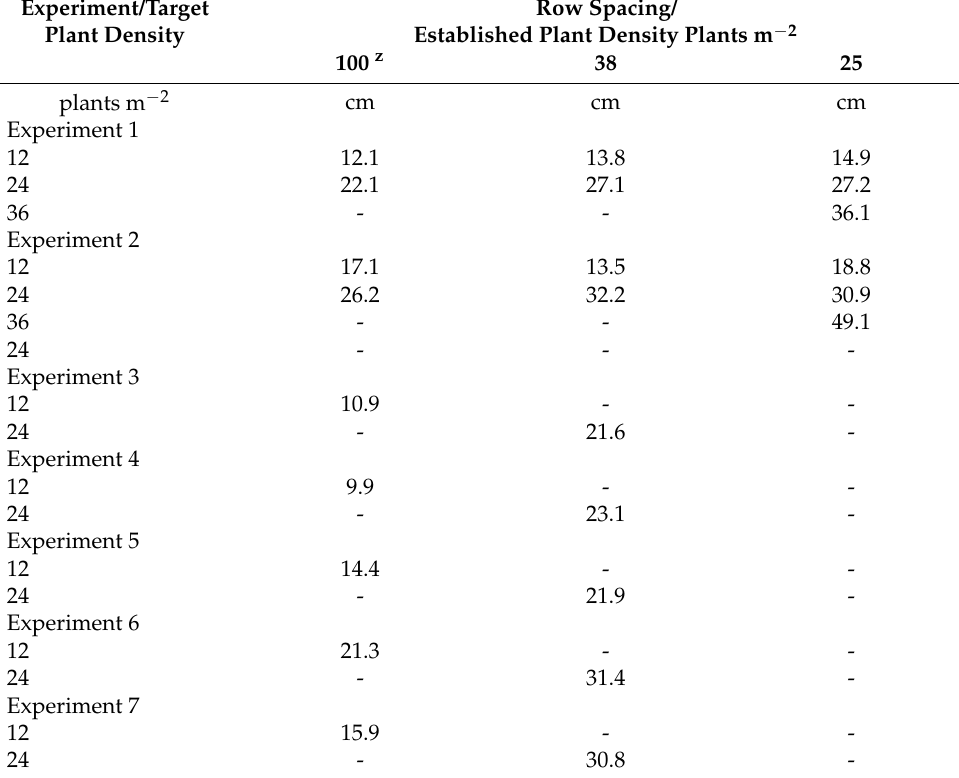
Table 2. Means of established plant densities for all treatment in each